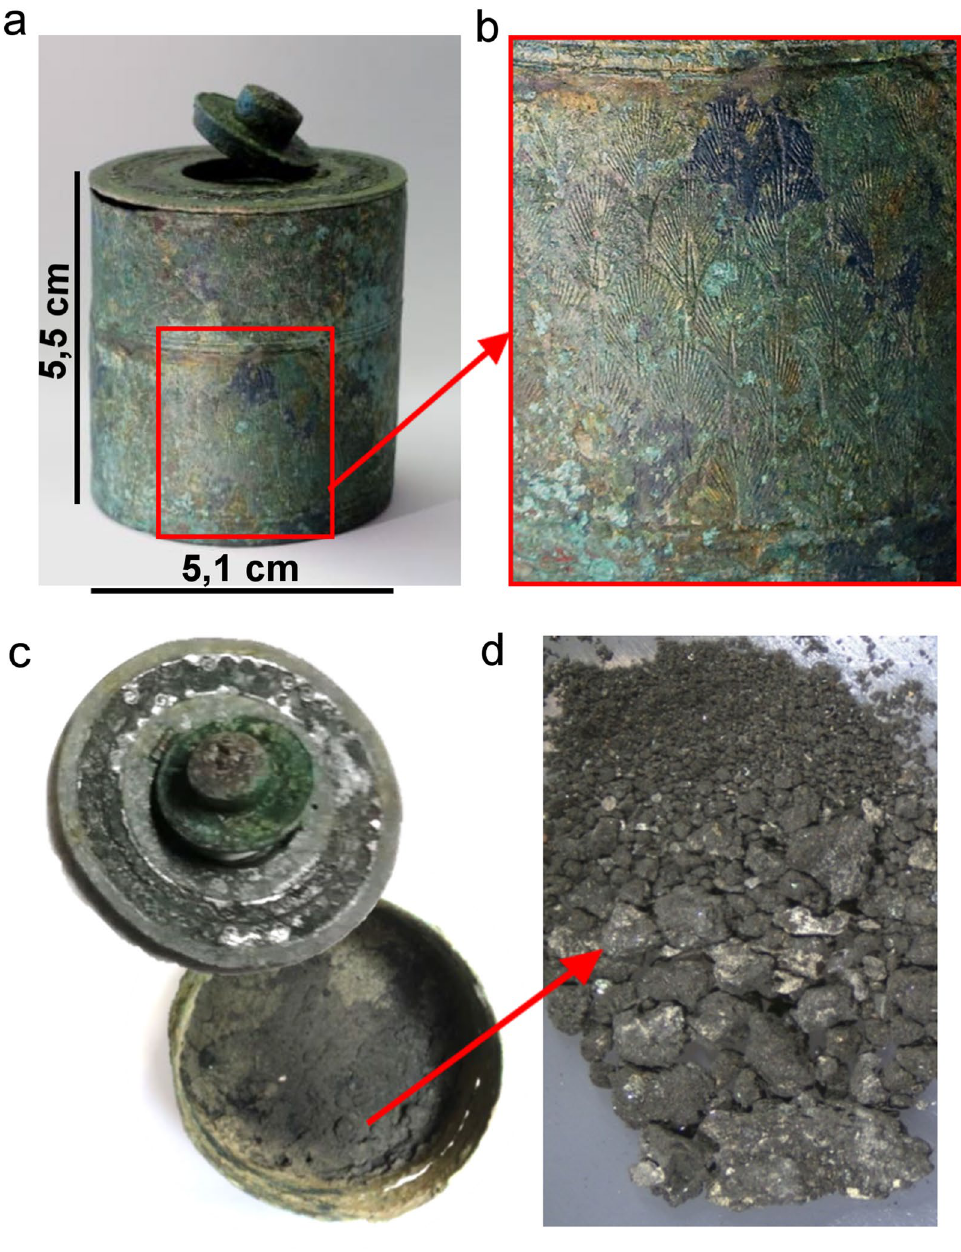
Figure 1. ( a ) the inkpot; ( b ) the inkwell bronze decoration; ( c ) an internal view of the inkwell with the black powder on the bottom; and a top view of the lid: traces of silver agemina are clearly visible; ( d ) the black powder with colored